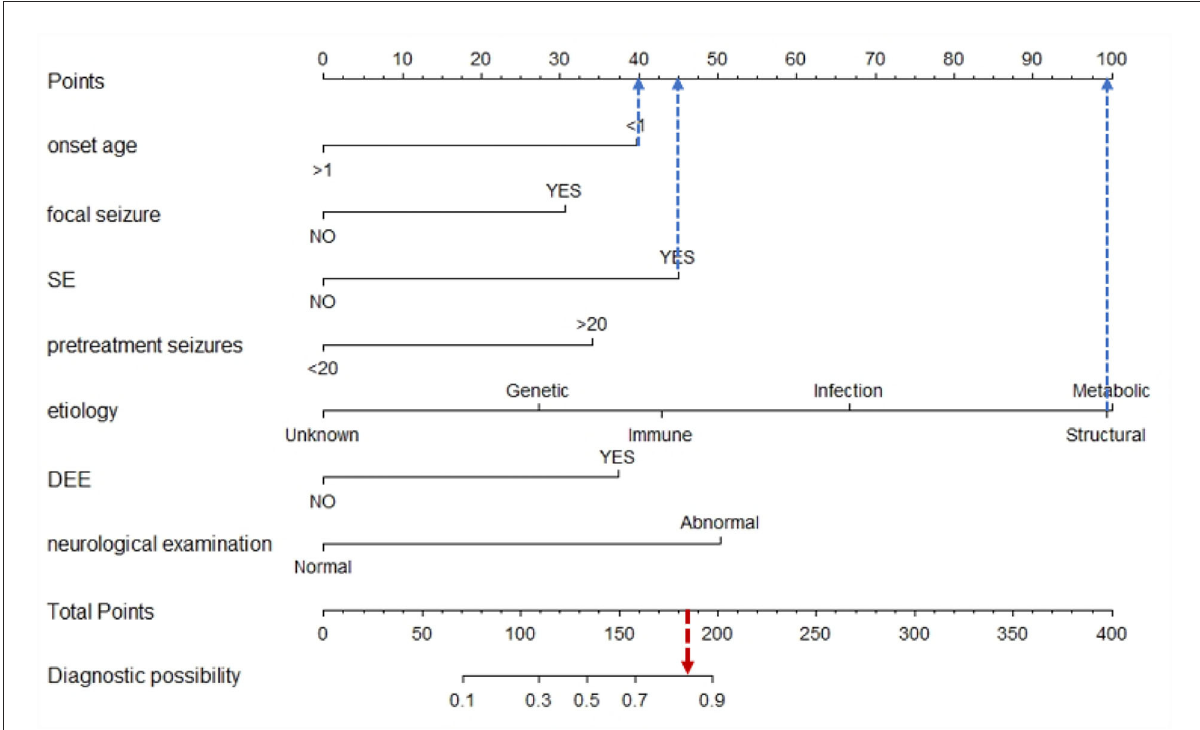
FIGURE3 Example of the nomogram prediction model for individual DRE. If there was an epileptic child aged 6 months old, with SE, structural etiology, 10 pre-treatment seizures, but without focal seizure, DEE, or neurological abnormalities, then the cumulative score of predicting factors was 40 + 45 + 99 + 0 + 0 + 0 + 0 = 184, and the corresponding likelihood for DRE was 0.84 (84%), indicating that this child was at 84% possibility for